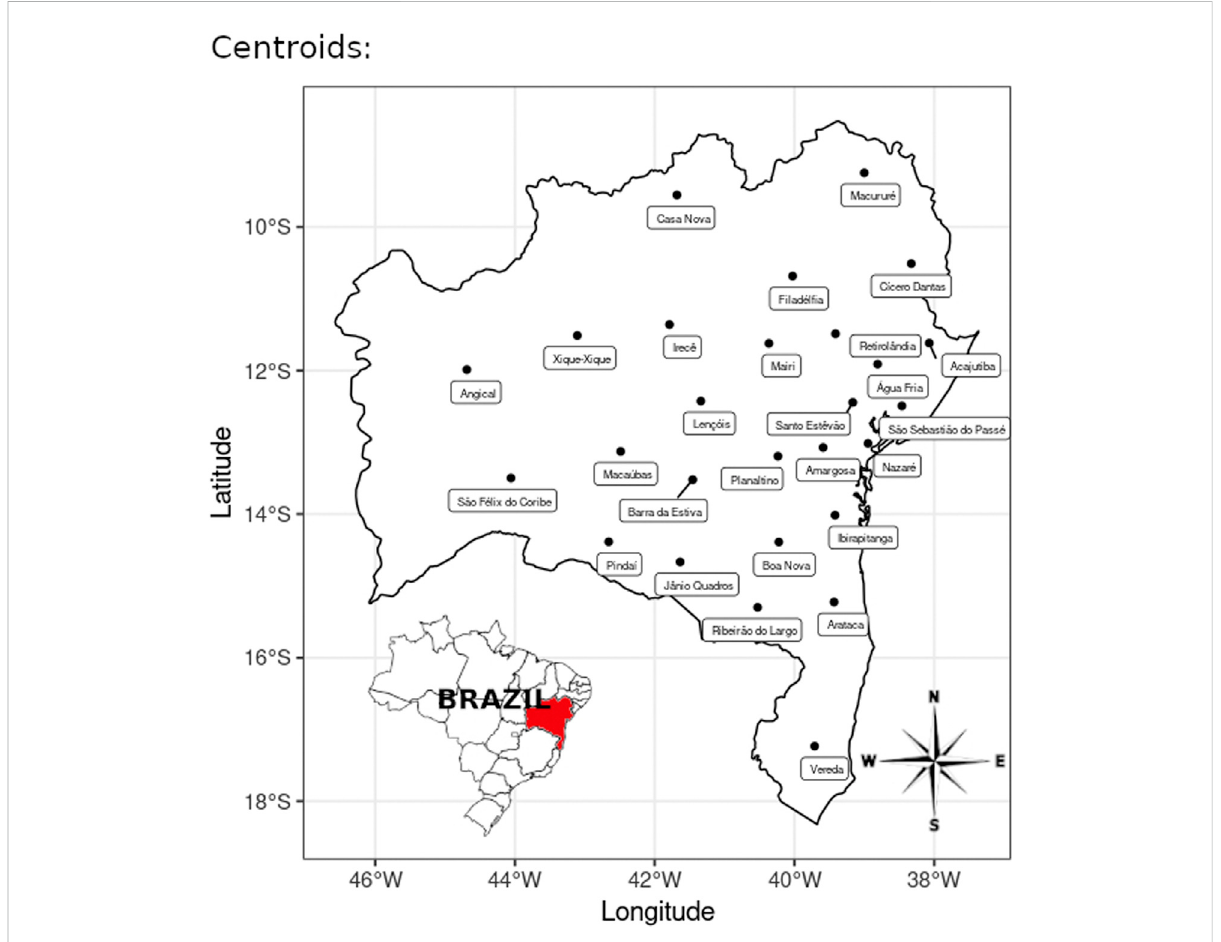
FIGURE 4 Medianofthe27clustersidenti fi edinthemapoftheStateofBahia,fortheGINI — distantassessmentofthedegreeofincomeconcentration,the HDI — international index of the human development level, and the SVI — index of social exclusion and vulnerability in the Brazilian